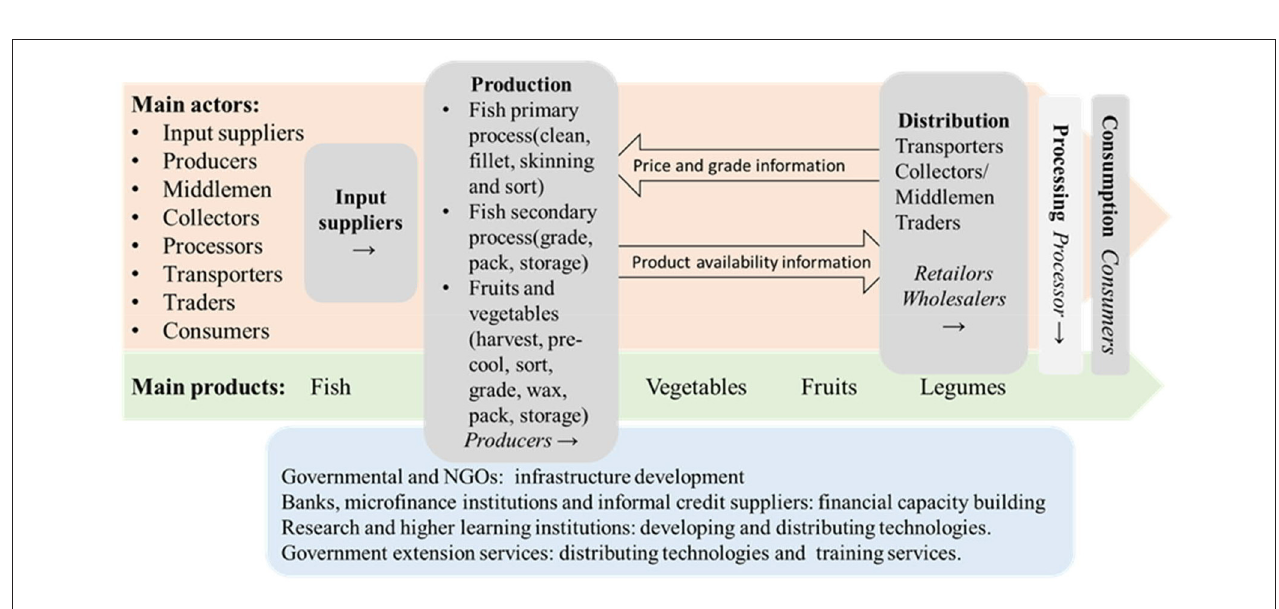
FIGURE 5 | The status quo of fish and vegetables, fruits, legumes value chains in Bahir Dar.